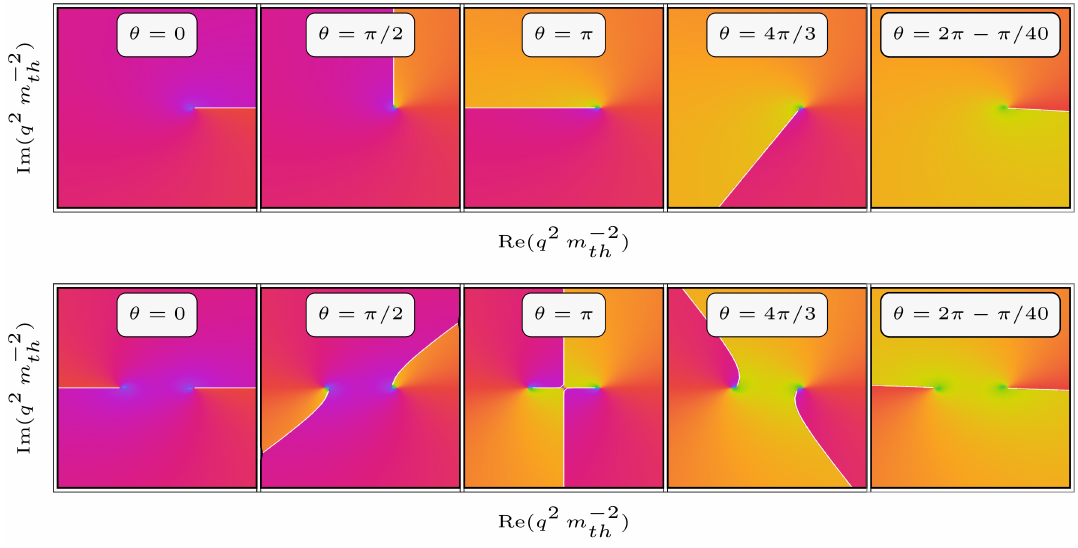
+ ξ ( q 2 /m 2 ) 2 )] , th th